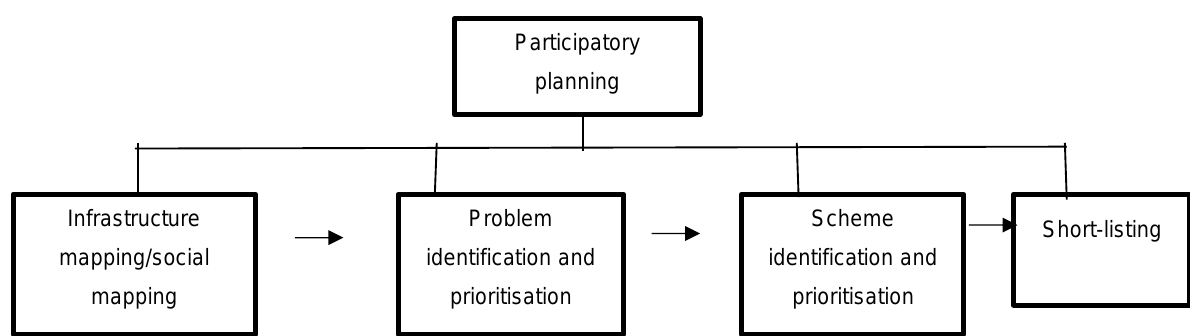
Figure 2: Steps in the PP process for UPs in Bangladesh